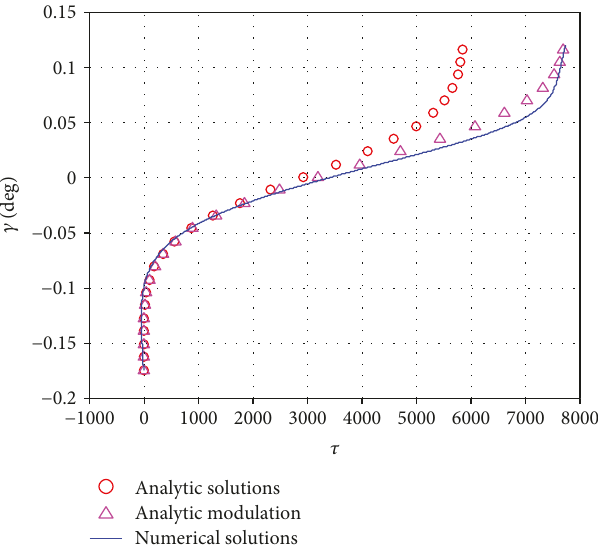
Figure 3: The corrected analytical solution vs. the numerical solution when γ 0 = − 10 °